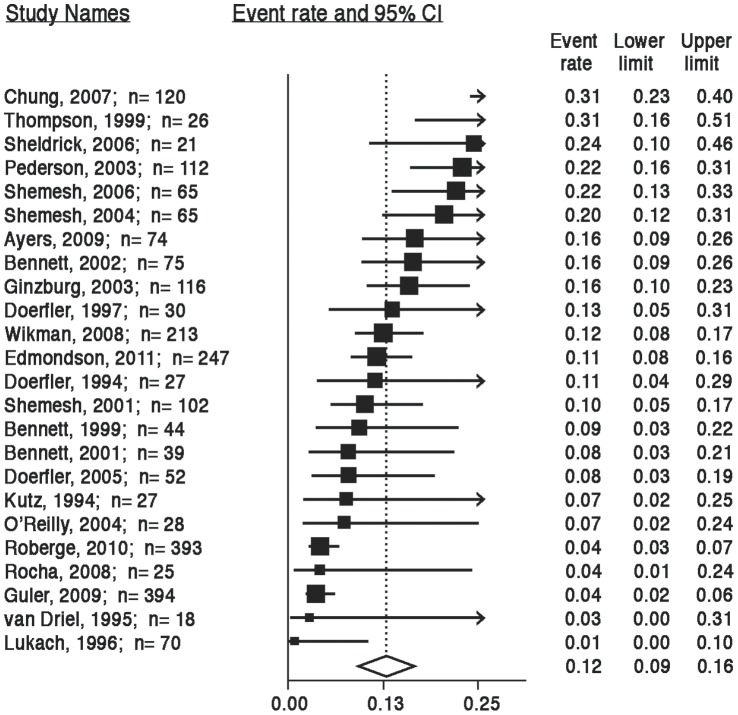
ACS-induced PTSD prevalence estimates.Note: The area of each square is proportional to the study’s weight in the meta-analysis, and each line represents the confidence interval around the estimate. The diamond represents the aggregate estimate, and its lateral points indicate confidence intervals for this estimate.